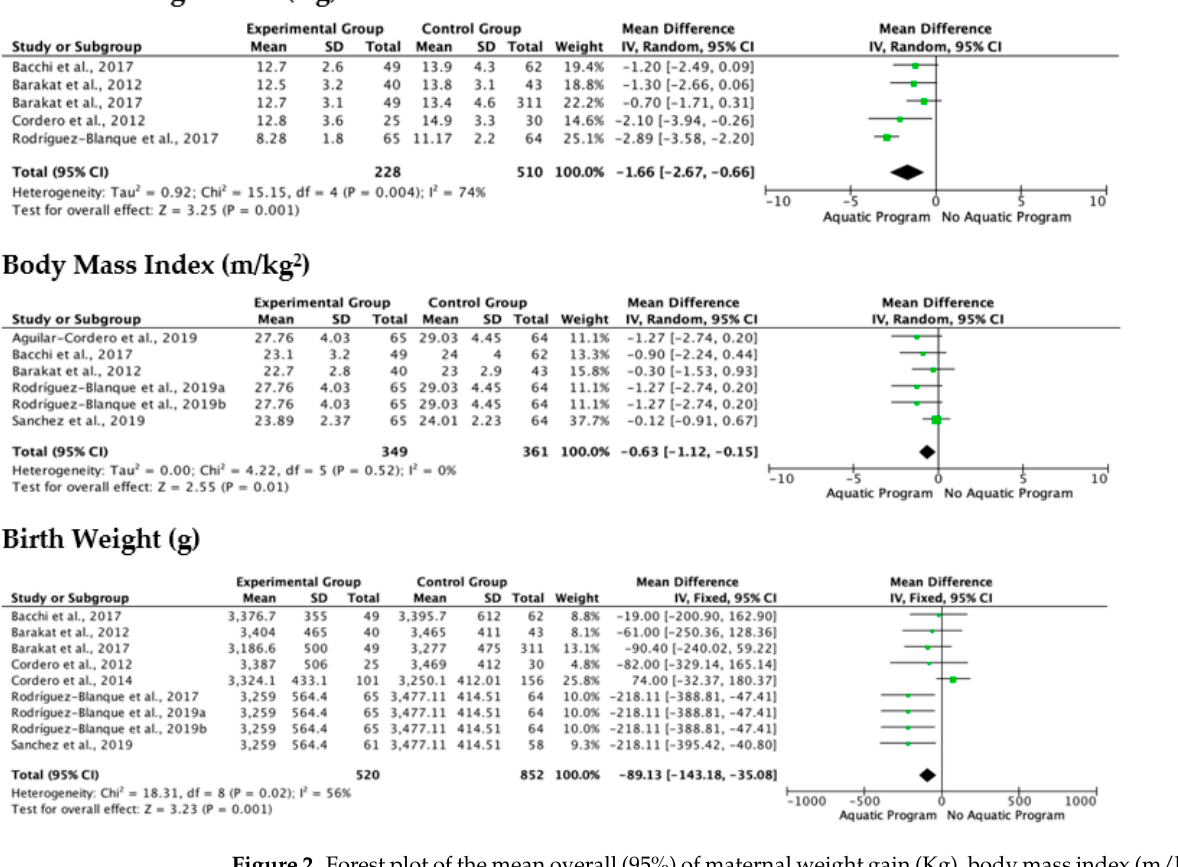
Figure 2. Forest plot of the mean overall (95%) of maternal weight gain (Kg), body mass index (m/kg 2 ) and birth weight (g) for each study included in the meta-analysis. Obs: Green square in-dicates the mean difference in each study. Black diamond indicates the mean difference of all stud- ies.